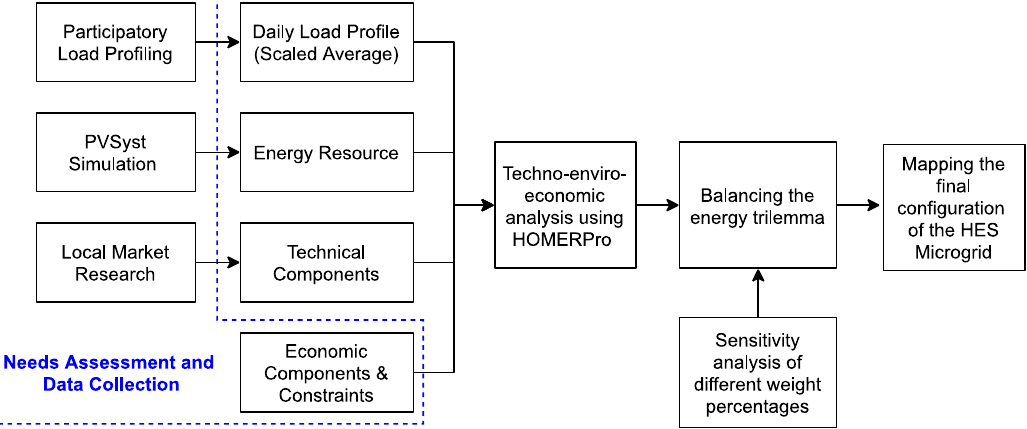
Figure 1. A schematic overview of the methodology used in this study.